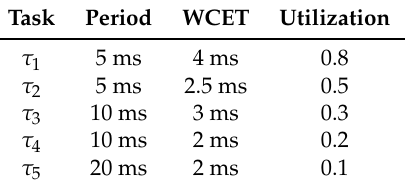
Table 8. Task properties.